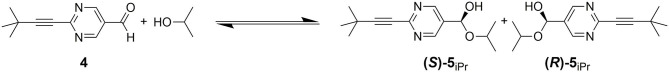
Hemiacetal formation of 2-(tert-butylacetylene-1-yl)pyrimidyl-5-carbaldehyde 4 with 2-propanol.